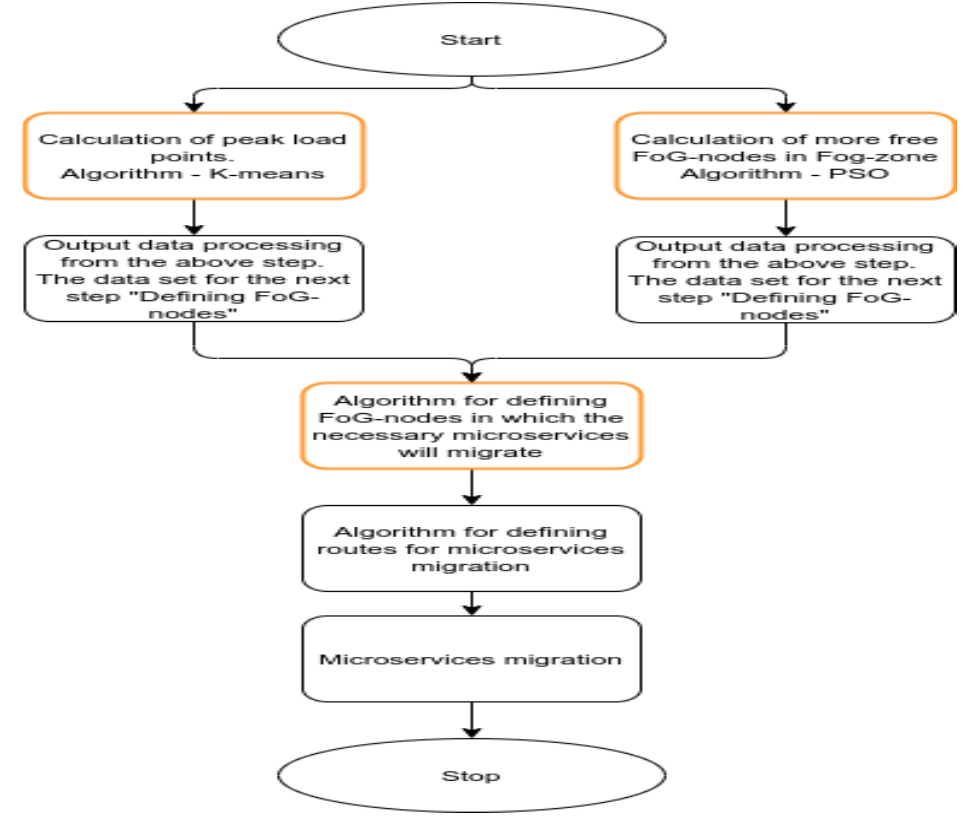
Figure 7. Framework